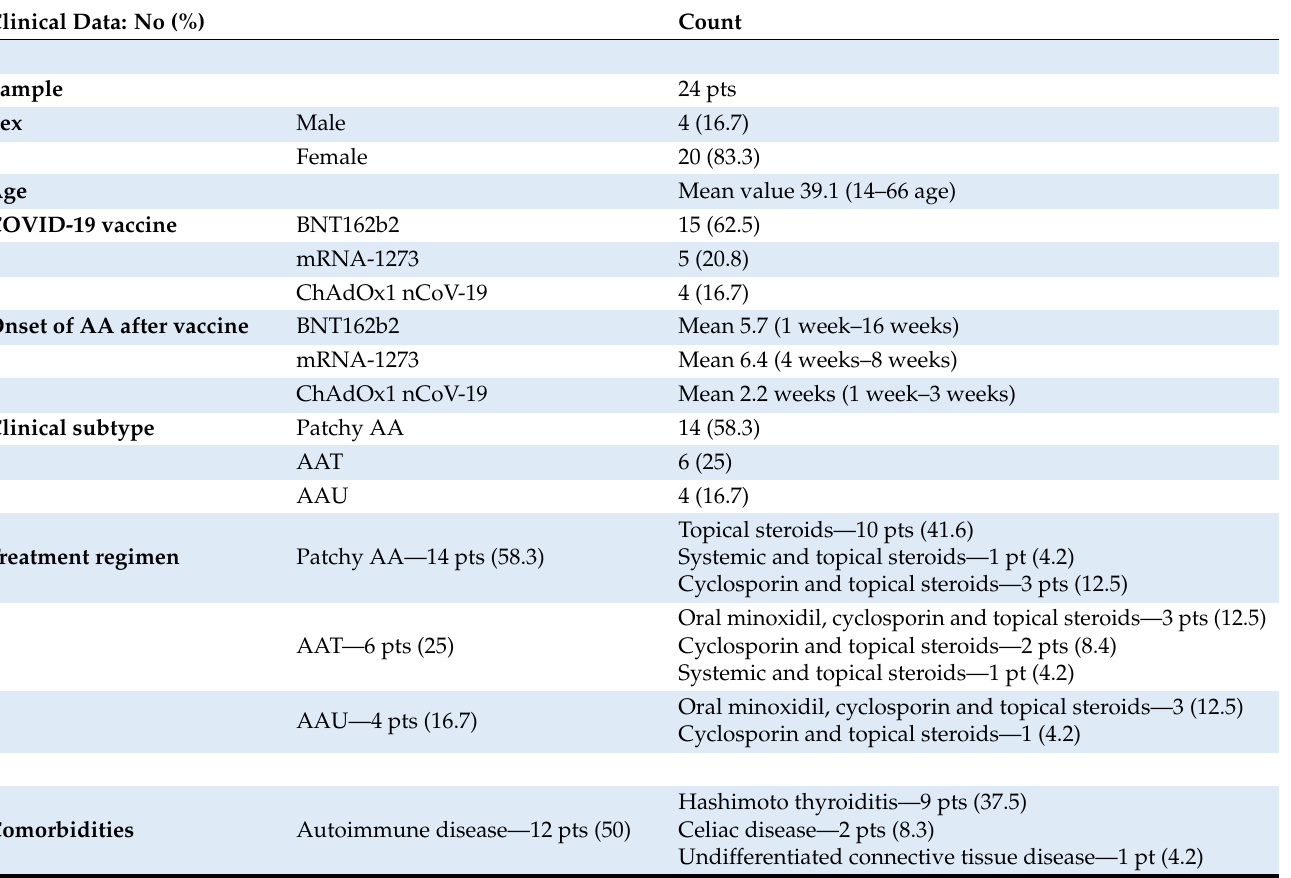
Table 1. Demographic and clinical characteristics of the patients: data related to vaccines and